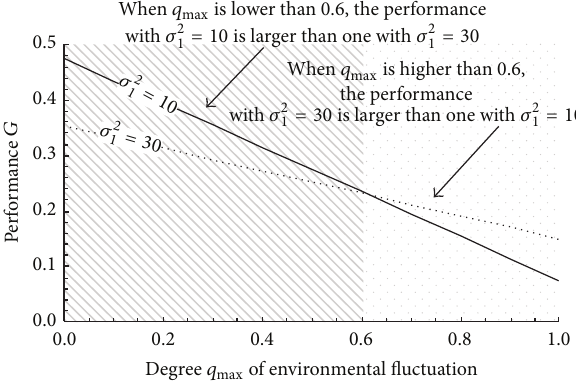
Figure 5: Tradeoff between robustness and